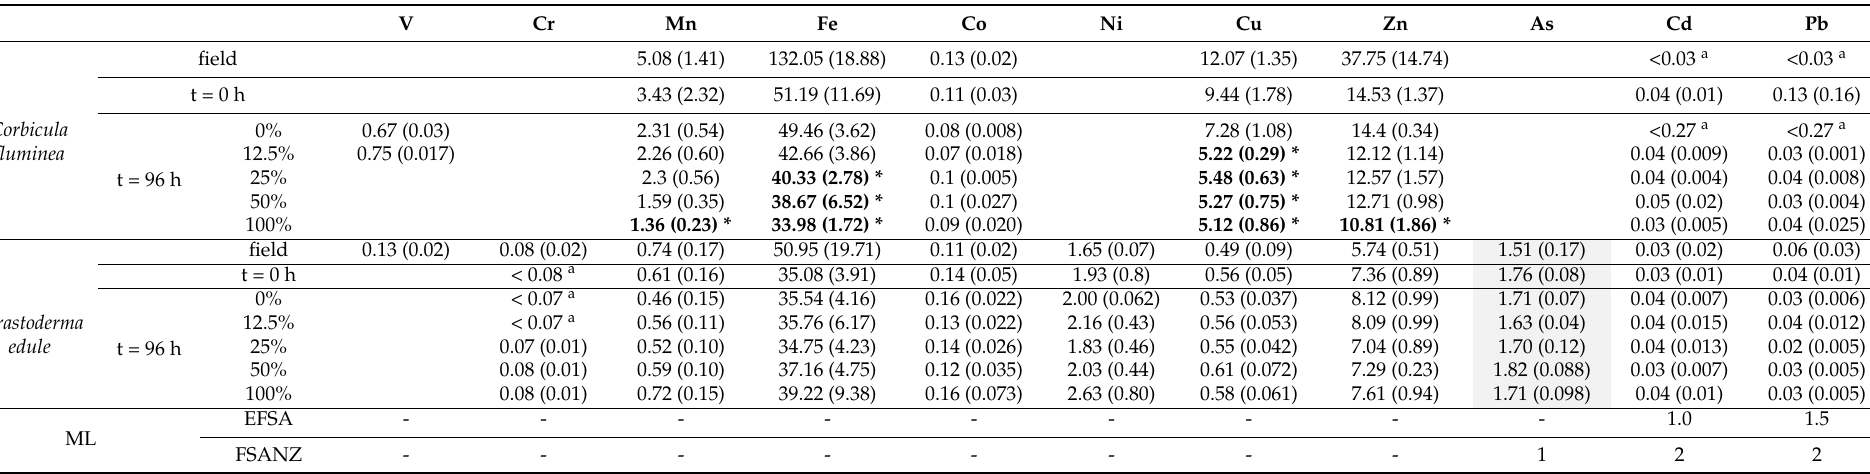
a metal concentration values were below the quantification limit. To allow statistical analyses, the presented values were determined considering the individual’s weight and assuming a metal concentration equal to the quantification